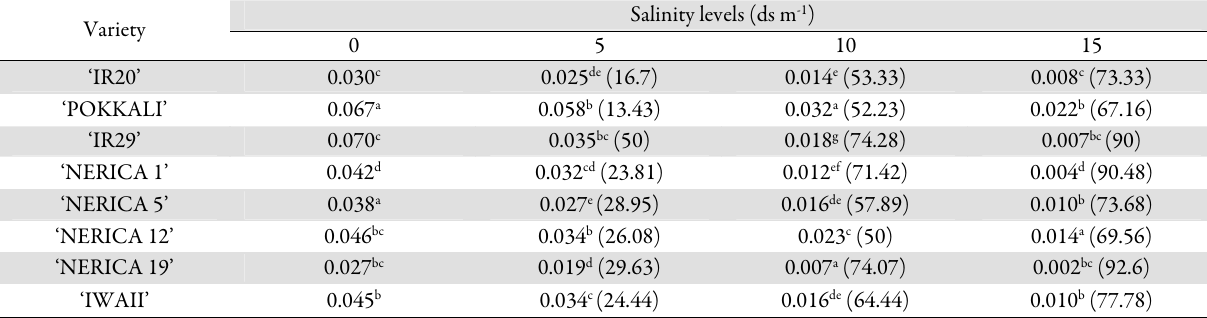
Means with the same letter in the columns do not differ significantly (p>0.05). Values in parenthesis indicate percent reduction of respective controls Tab. 5. Effect of salinity on root dry weight (g/5 plants) of different rice